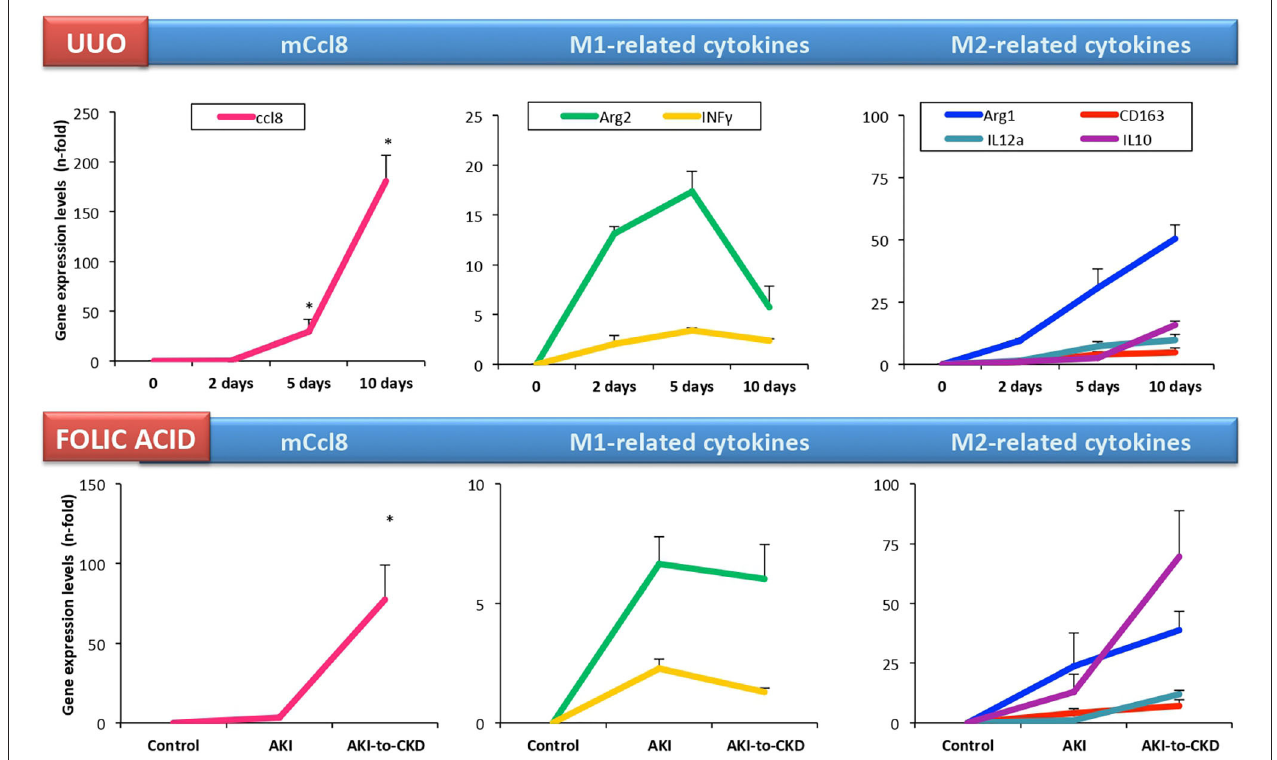
FIGURE 3 | Kidney Ccl8 gene expression is associated to M2 cytokines in experimental kidney injury. Kidney Ccl8 expression and M1 and M2-related factors were evaluated in CKD models: unilateral ureteral obstruction (UUO) and the acute and chronic phase of folic acid (FA) nephropathy mice [data from Cantero-Navarro et al.